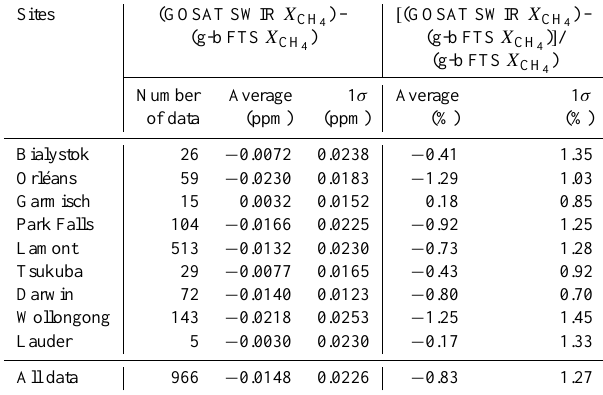
Table B2. As in Table B1 except for X CH